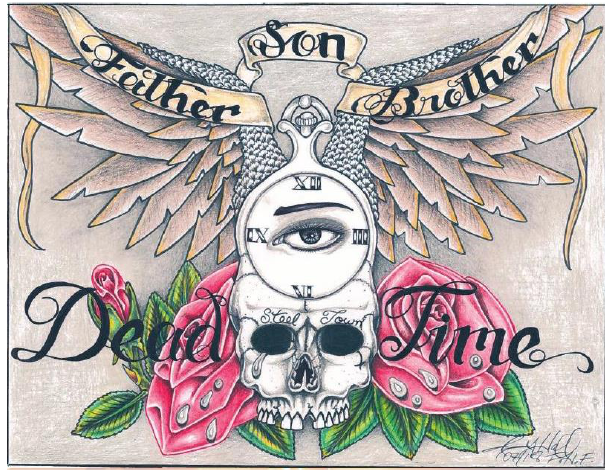
Figure 1: Cover of Cell Count , vol. 85 (FHF 2018: